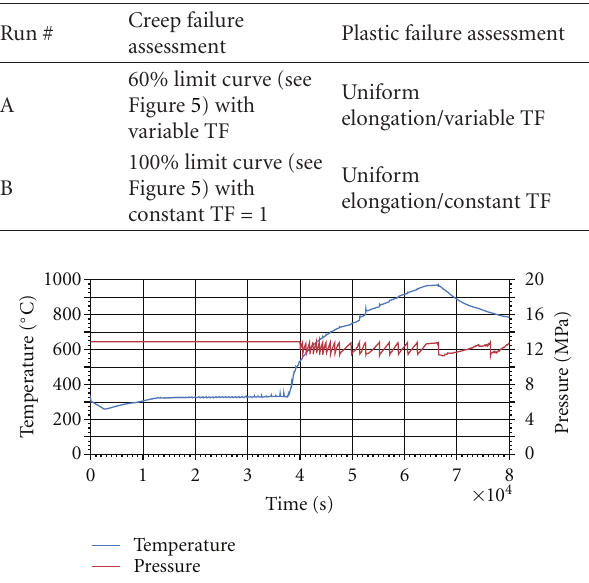
Figure 10: Temperature and pressure progression.